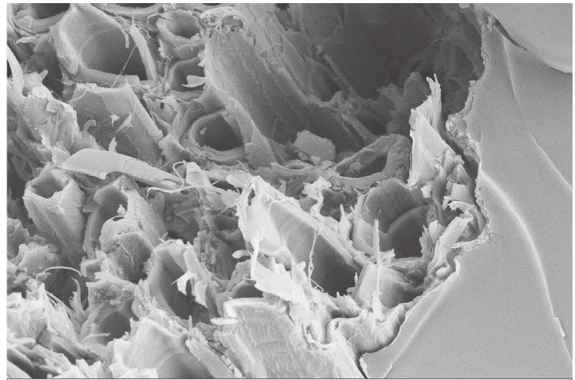
Figure 2: Scanning electron microscope image of Sansevieria ehrenbergii fiber.